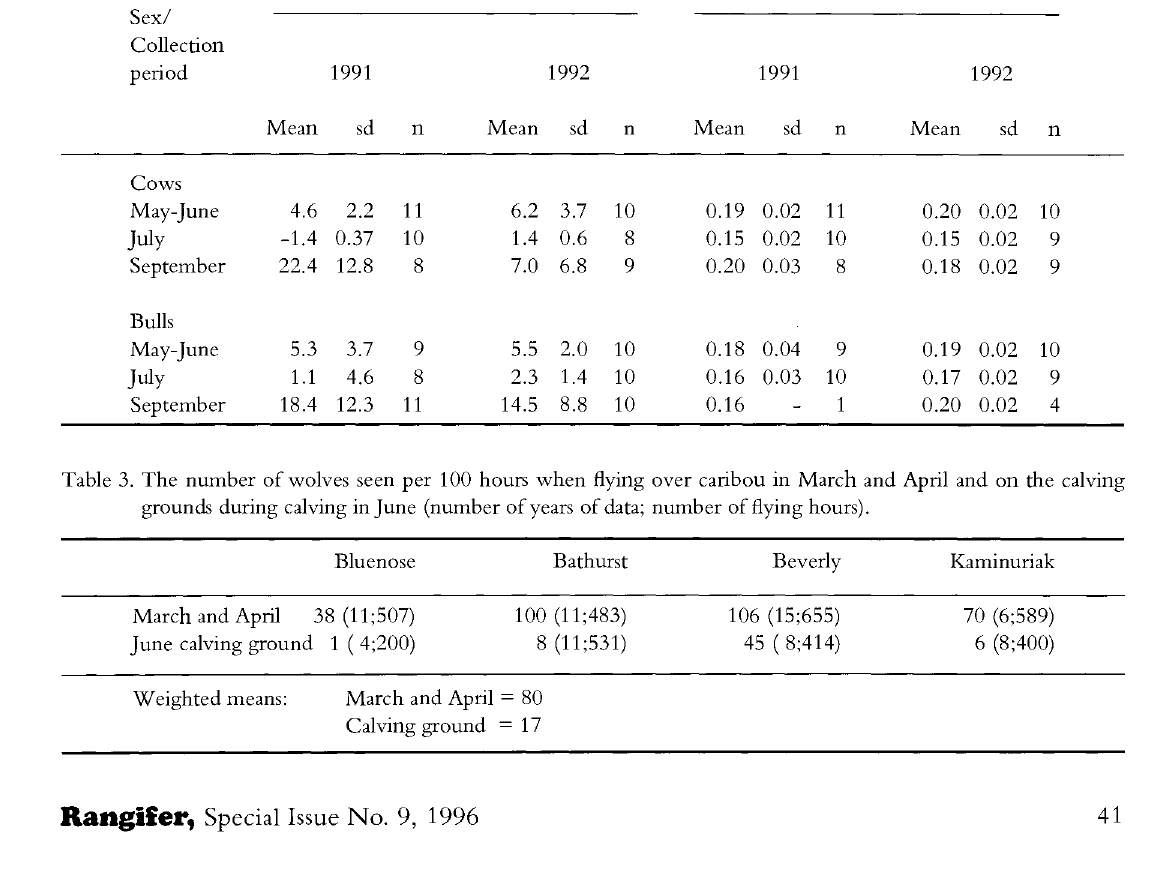
Table 2. Seasonal changes in fat and muscle weights of bulls and cows in the Bathurst caribou herd in 1991 and 1992. Fat index Muscle index